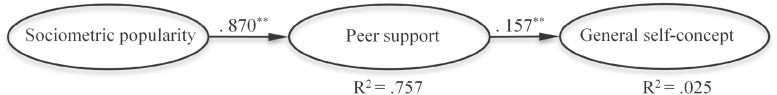
Final structural model.